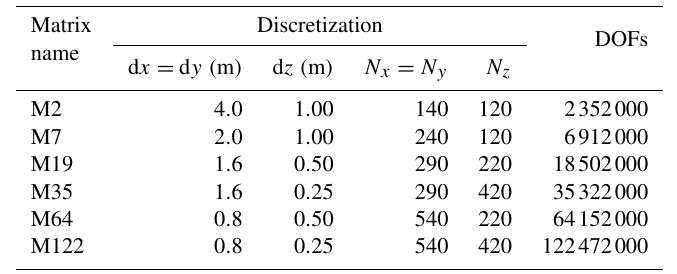
Table 1. Test matrices obtained by rediscretizing the three-layer earth model in Fig. 3 using different cell sizes d x , d y , and d z in the x , y , and z directions. N x , N y , and N z are, respectively, the number of FV cells in the x , y , and z directions. Note that the cell sizes are given only for the main computational domain; the boundary domain is discretized using severely stretched non-uniform cell sizes.